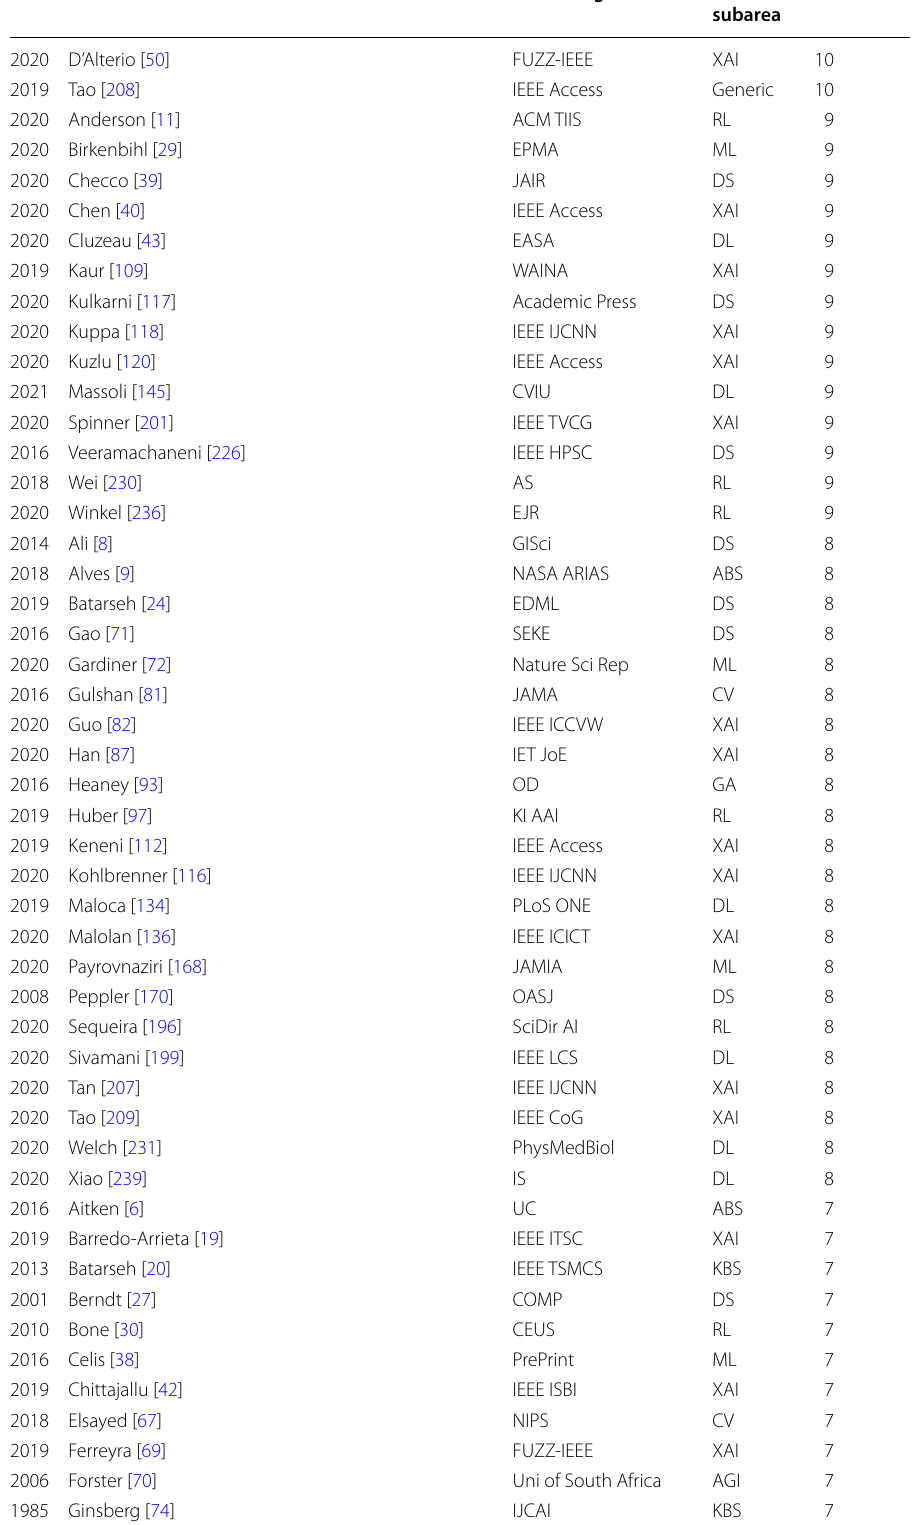
Table 1 Reviewed methods and their total